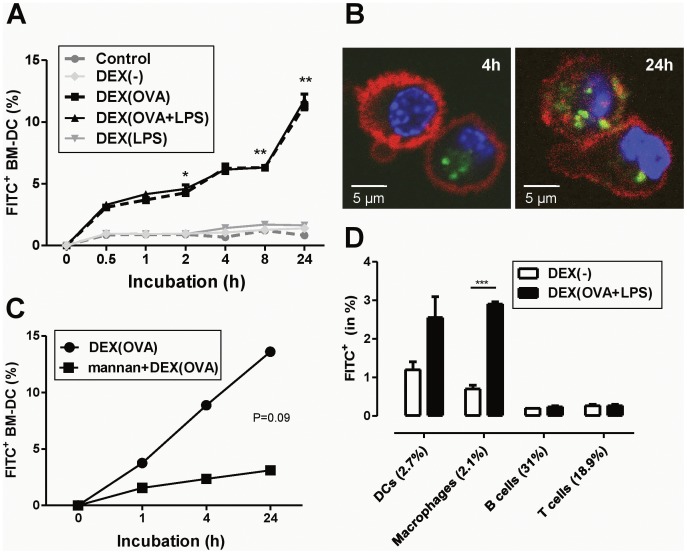
BM-DCs engulf DEX particle formulations in an OVA-dependent manner, mainly via the MR.Aliquots of unstimulated day 6 BM-DCs (5×105 cells; C57BL/6) were left untreated (−) or were coincubated with FITC-labeled DEX particles in duplicates as indicated (each 50 µl). (A) Aliquots were removed after the indicated period of time, and the frequencies of FITC+CD11c+ BM-DCs were assessed by flow cytometry. Data represent mean±SEM of duplicates and are representative of three independent experiments. Statistical significant differences between OVA-containing DEX particles (DEX[OVA], DEX[OVA+LPS]) and the corresponding control group (DEX[−], DEX[LPS]) are indicated for each time point (*p<0.05, **p<0.01). (B) Cellular uptake of FITC-labeled DEX(OVA) by BM-DCs, stained with anti-CD11c antibody (red) and DAPI (blue), was assessed by confocal laser scanning microscopy 4 h (left panel) and 24 h (right panel) after the onset of coincubation. (C) In parallel cultures, aliquots of BM-DCs were left untreated or were incubated with mannan at high dose (200 µg/ml) for 30 min. Afterwards, DEX(OVA + LPS) was added to either group. Aliqouts of BM-DCs were harvested at the indicated time points, stained for CD11c, and analyzed by flow cytometry. Data represent mean±SEM of duplicates and are representative of three independent experiments. (D) Spleen cells derived from C57BL/6 mice (2×106 cells/200 µl) were left untreated (data not shown) or were coincubated with FITC-labeled DEX particles as indicated (each 30 µl) for 24 h. Afterwards, the cells were stained with either of the indicated cell lineage markers (DCs: CD11c-PE-Cy7, Macrophages: F4/80-eFlour405, B cells: CD19-APC, T cells: CD3-PE), and were analyzed by flow cytometry for the frequency of FITC+ cells within either lineage. Numbers in brackets indicate the overall frequency of either cell lineage within the spleen cell suspension. Data represent mean±SEM of three independent experiments. Statistical significant differences between groups are indicated (***p<0.001).